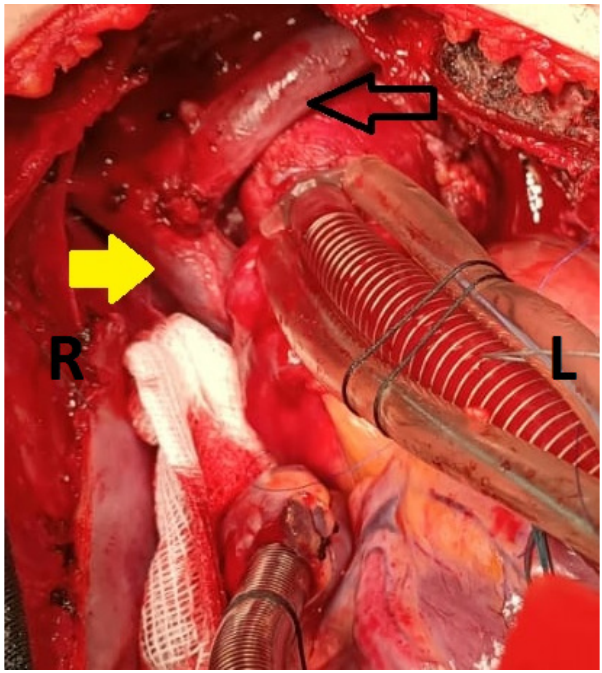
Fig. 1 - Persistent left superior vena cava was carried over the ascending aorta and anastomosis was performed to the medial aspect of right superior vena cava. Black arrow=persistent left superior vena cava; yellow arrow=right superior vena cava; L=left; R=right